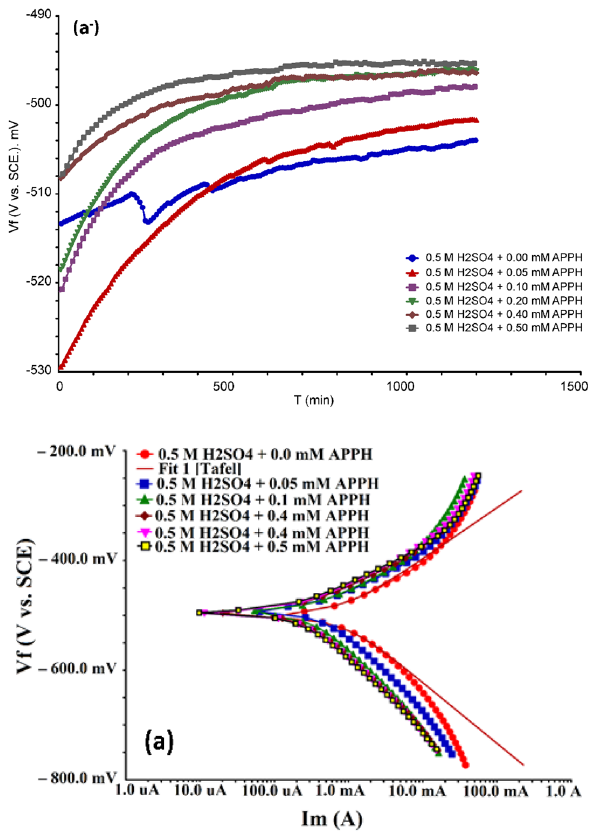
Figure 1. ( a − ) OCP and ( a ) Tafel polarization grave for LCS in 0.5 M H 2 SO 4 with different concentrations of APPH at 303 K.